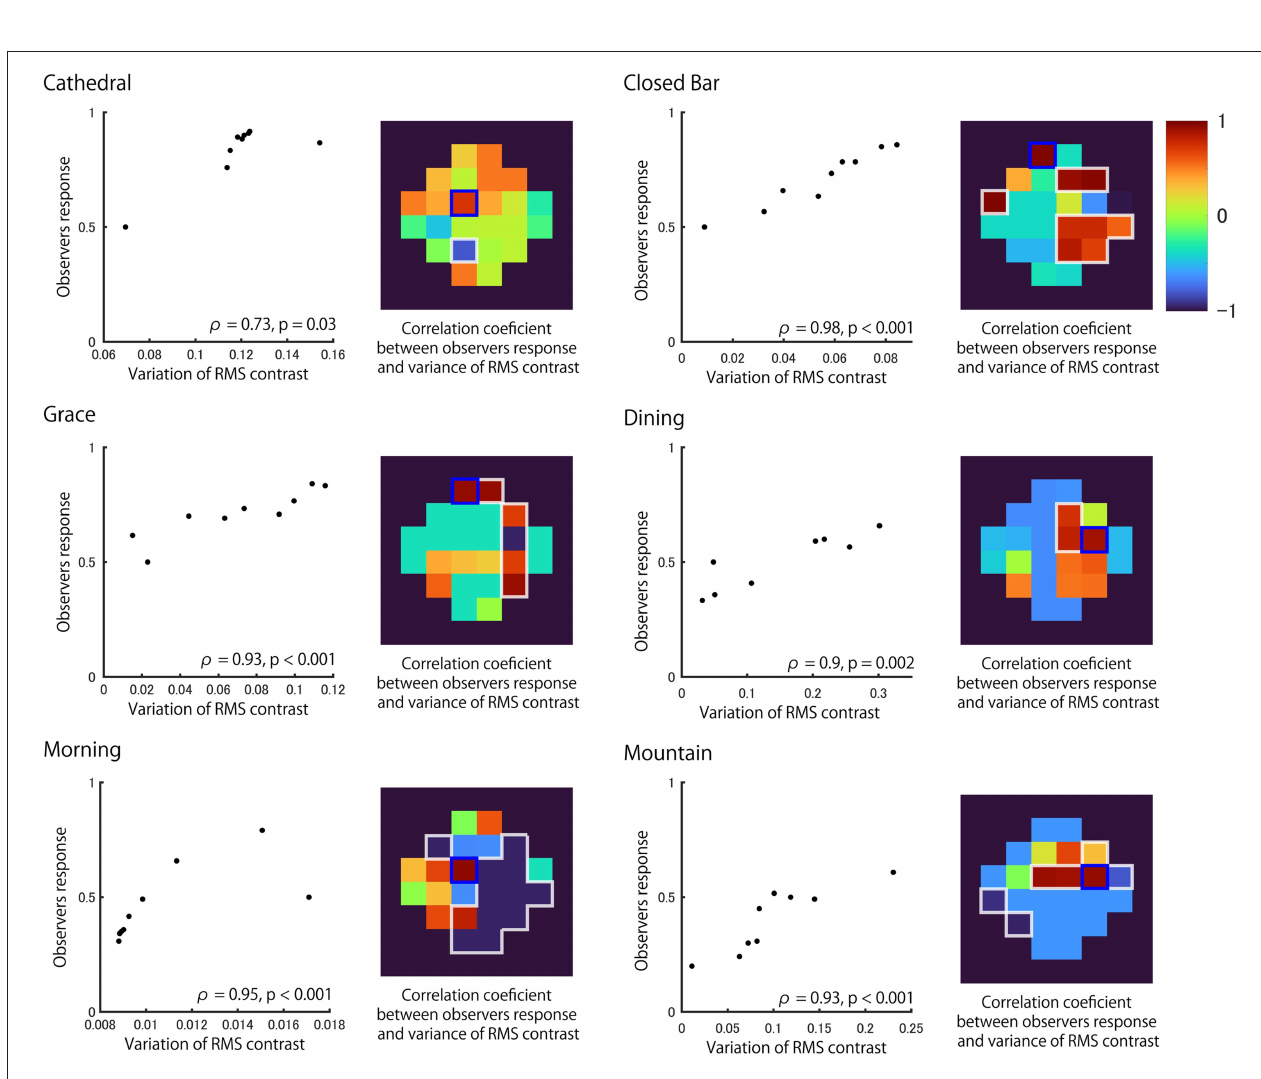
FIGURE 6 | Correlation between local RMS contrast variability and observer responses for each light probe. Correlation plots between the variance in local RMS contrast of the region with highest correlation (denoted by blue square in heatmap) and the observers’ response in each light probe. Data includes the reference (matte) stimulus where the corresponding response was assumed to be 0.5. Heatmaps show the Spearman’s rank correlation coefficient calculated separately for each region. The region with white outline shows significant correlation ( p < 0.05).